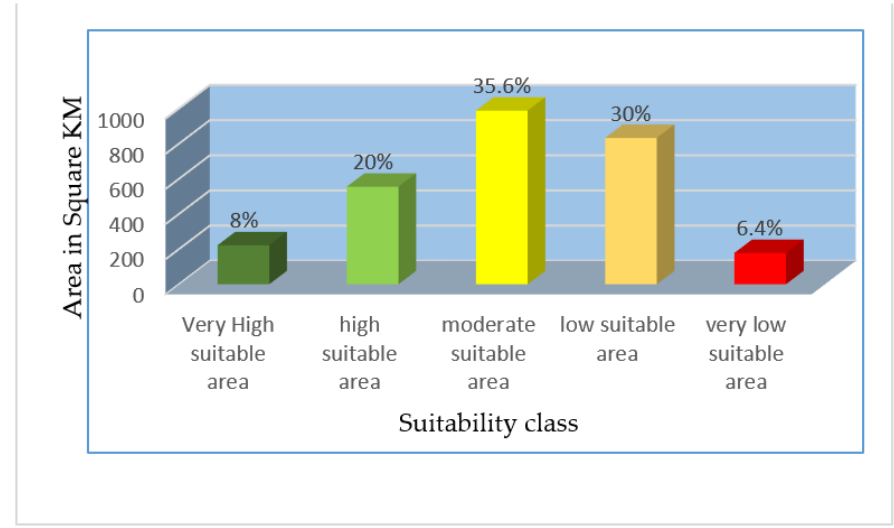
Figure 11. Percentage of the area with different rainwater harvesting suitability.